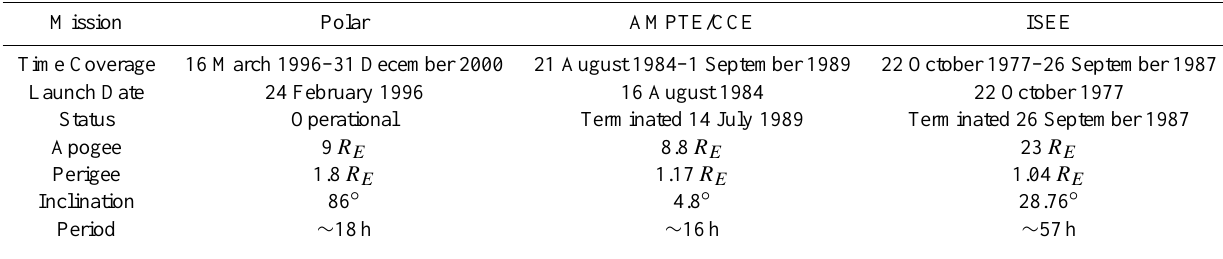
Table 1. Data Set